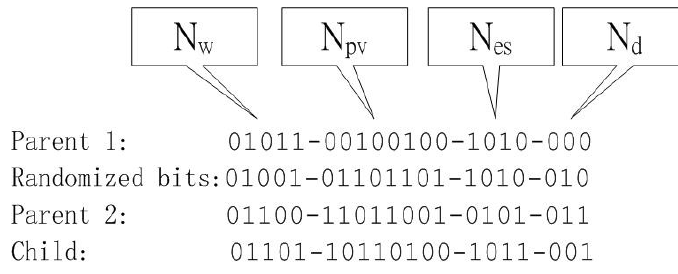
Figure 2. Crossover operations applied to two